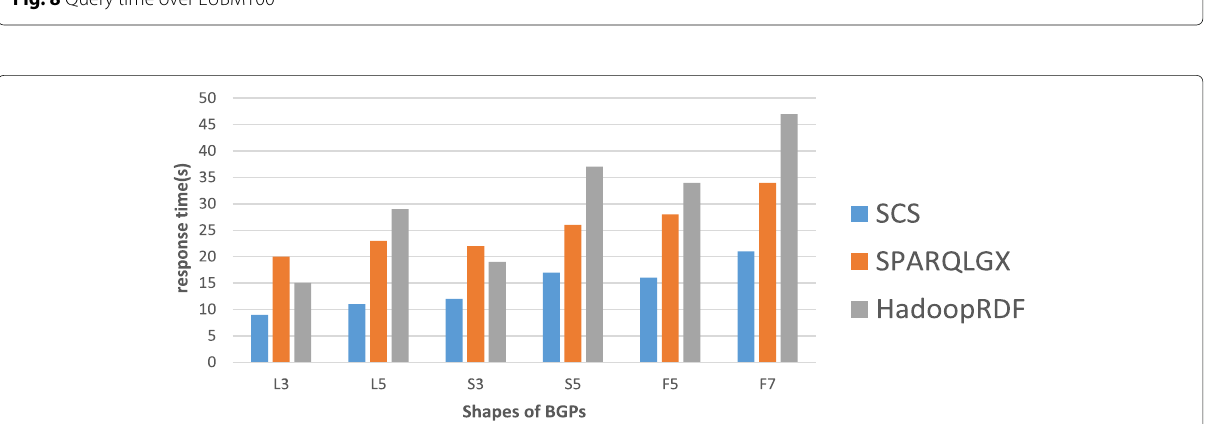
Fig. 9 Query time over